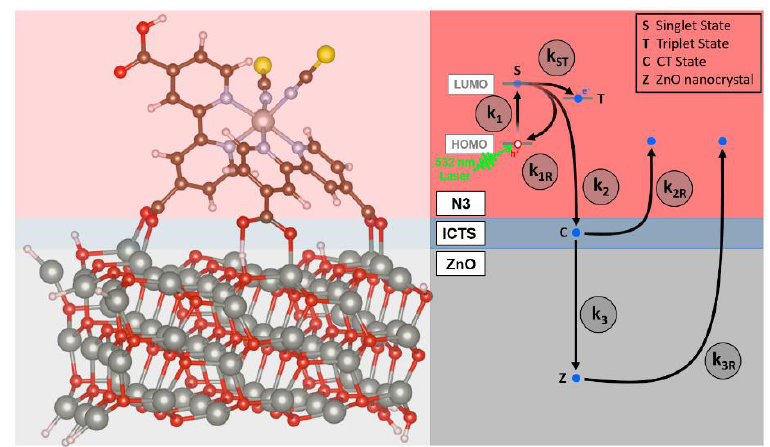
Fig. 2. Left: Predicted dominant binding motif of N3 dye molecules on wurtzite ZnO substrate. Right: Relevant rates contributing to interfacial charge-transfer and relaxation dynamics following photoinduced HOMO-LUMO excitation of the N3 dye. Labels mark molecular singlet [S] and triplet [T] states, interfacial charge-transfer states [C], and delocalized conduction band states [Z]. Electron- hole recombination rates involving different states are indicated by an index